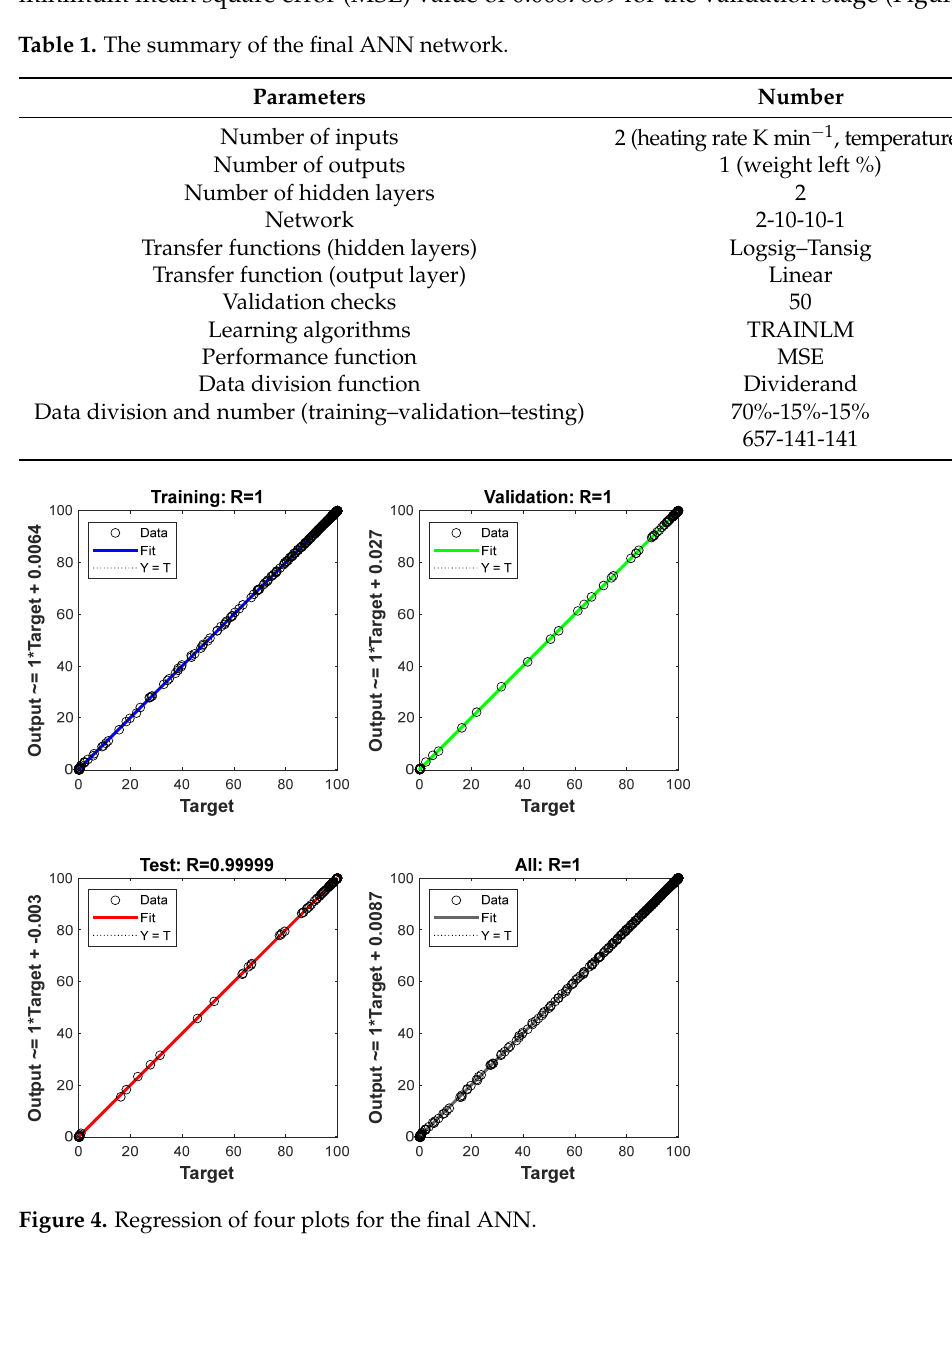
Figure 5. Mean square error for three plots.